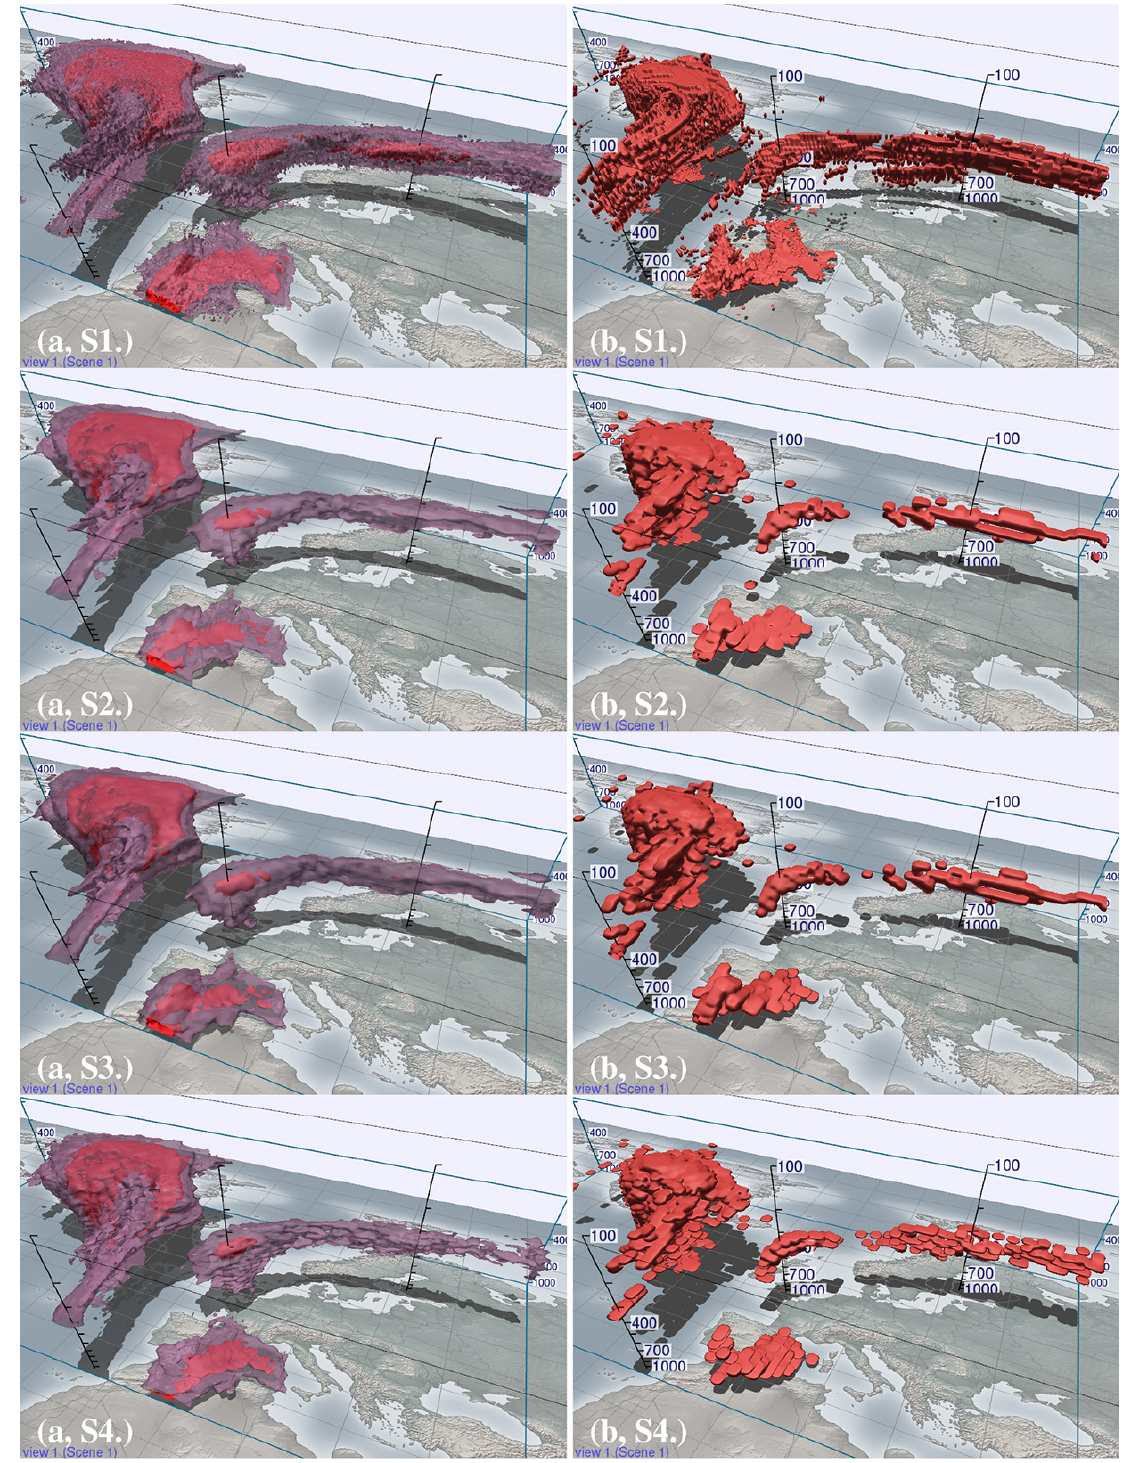
Figure 5. Comparison of set-ups to compute p( WCB ) . Same forecast as in Fig. 3. The selection criterion is set to 500hPa in 48h. (a) Volume rendering of p( WCB ) (red opaque isosurface shows 30% probability, purple transparent isosurface 10% probability). (b) Volume rendering of the binary grid B of a single member (member 12), representing the WCB features for this member. (S1) DF-T set-up with a horizontal grid spacing of 0 . 25 ◦ × 0 . 25 ◦ , in the vertical the lower 52 (of 62) hybrid sigma-pressure levels (up to approximately 100hPa) defined by the ensemble minimum surface pressure are used. (S2) As (S1) but with 1 ◦ × 1 ◦ horizontal grid spacing. (S3) As (S2) but with vertical levels defined by a constant surface pressure of 1000hPa. (S4) ABL-T set-up with 1 ◦ × 1 ◦ horizontal grid spacing and a regular vertical grid with a grid spacing of